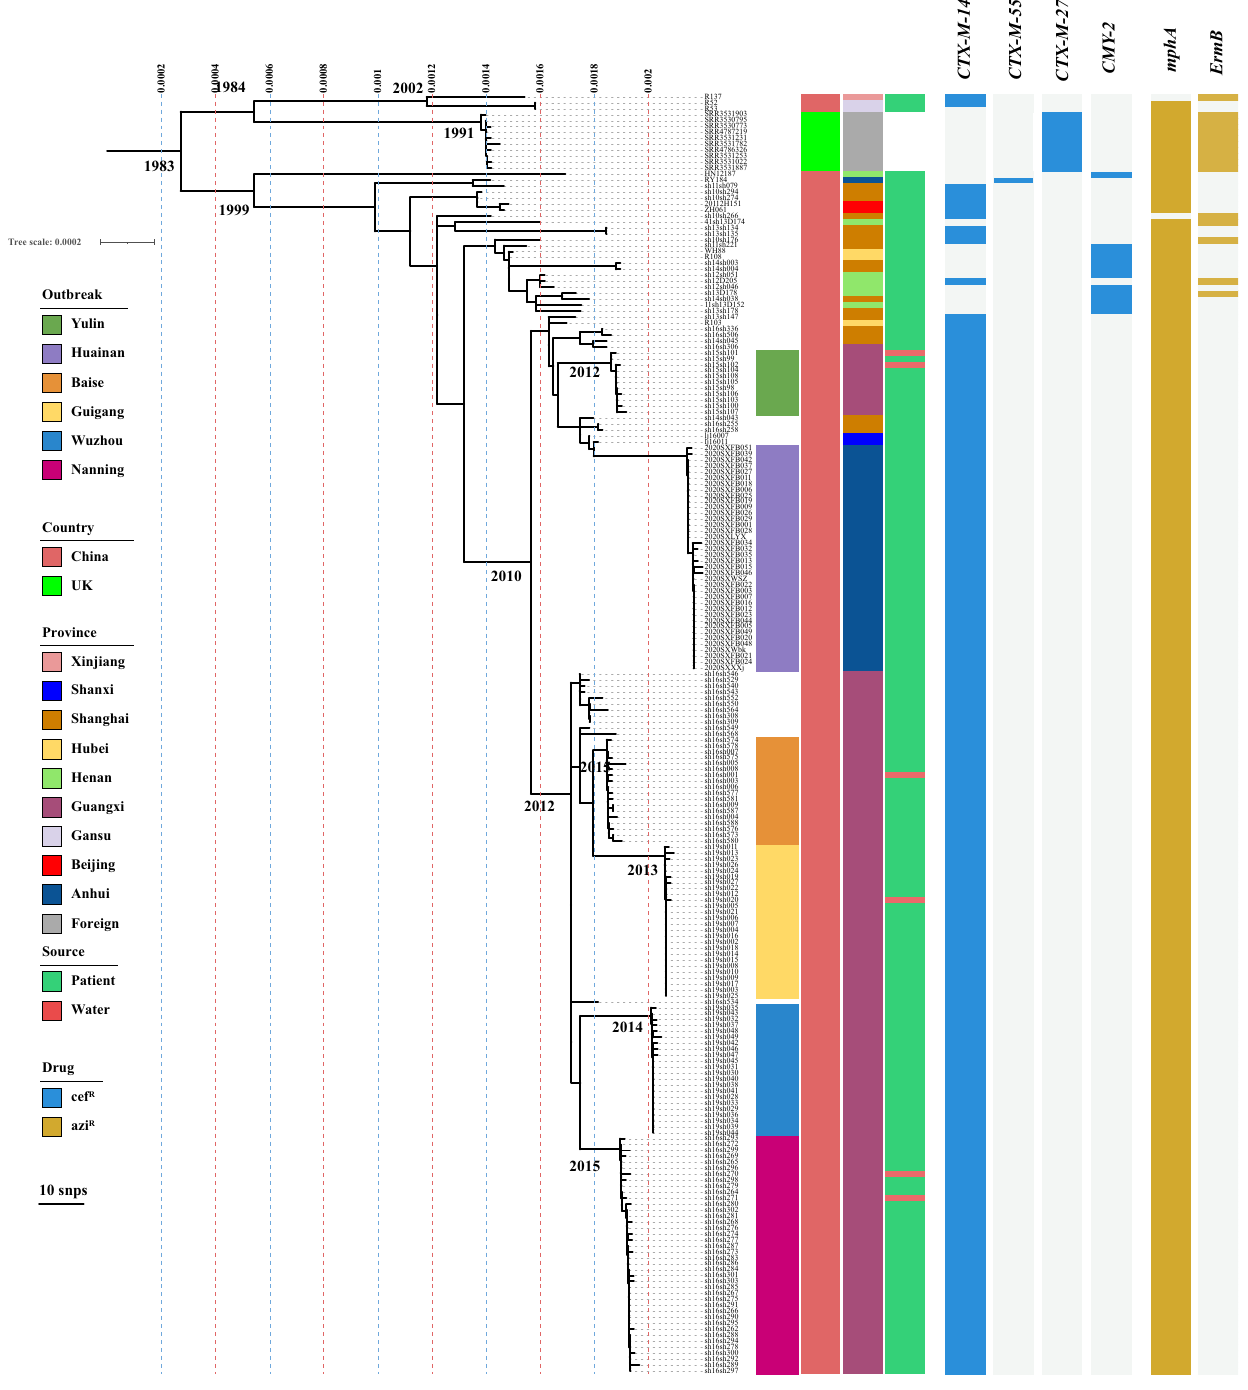
Fig. 2 | Microevolution of the cef R azi R S. sonnei strains including the outbreak strains. The phylogenetic tree was constructed based on 215 cef R azi R S. sonnei isolates, including 205 Chinese strains and 10 UK strains. The outbreak locations, isolation regions, geographical origin, and isolation sources (patient or water) are labeled in different colors. The AMR genes conferring cef R azi R coresistance are